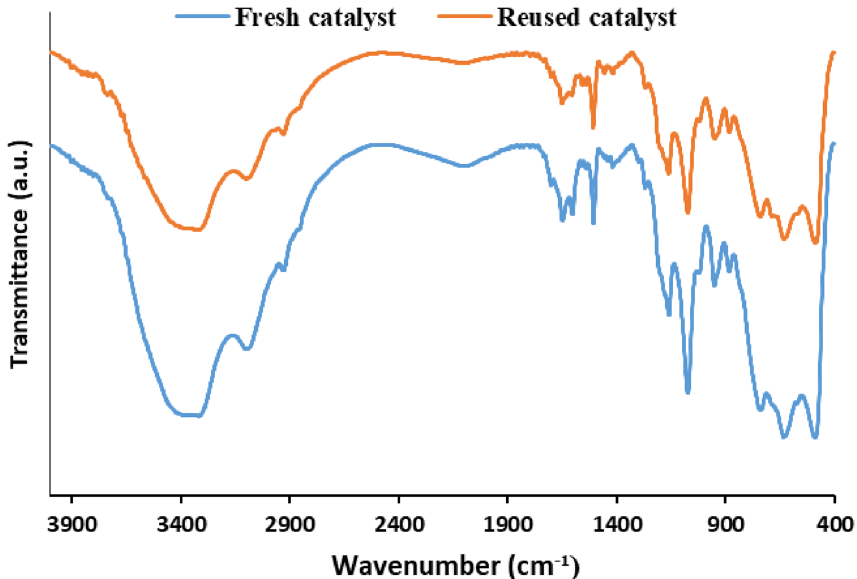
Figure 10. Comparison of the FTIR spectra of fresh and reused Pd/B-CP-HIm after the last run of the model hydrogenation